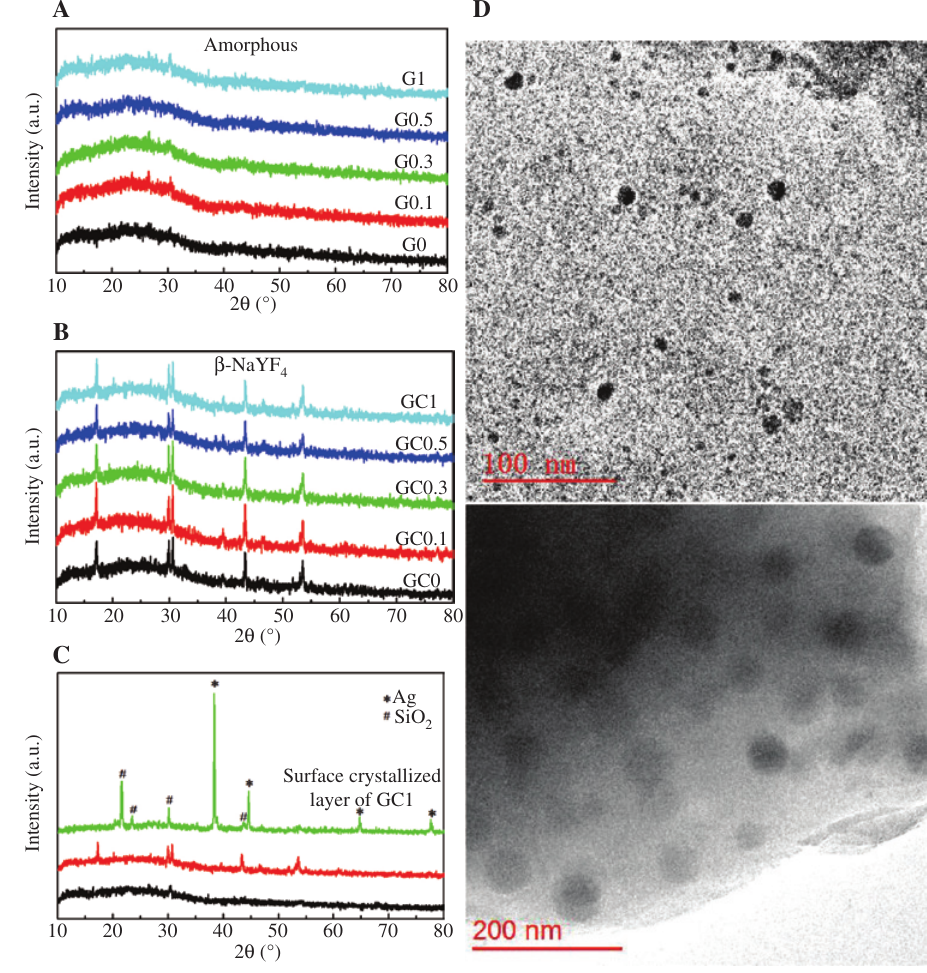
Figure 1: Morphological characteristics of glasses and GCs. XRD patterns of glasses (A) and GCs (B); (C) comparison of the XRD patterns for the G1 sample, GC1 sample, and surface crystallized layer of the GC1 sample; TEM micrographs of Ag NPs (D) and β -NaYF